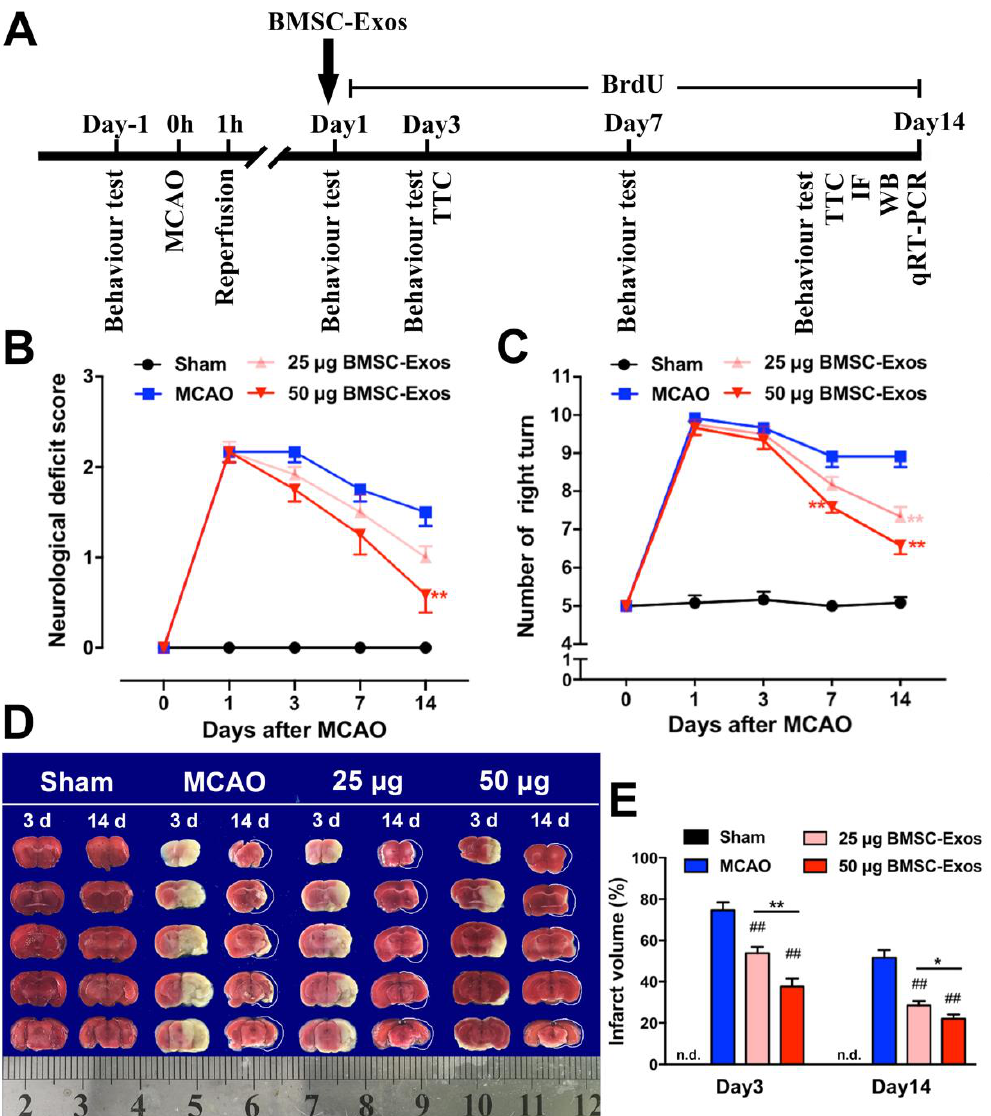
Figure 3. BMSC-Exos administration improved behavioral outcomes and reduced infarction volume in MCAO mice. ( A ) Schematic represents the timeline of in vivo experiments. ( B ) Neurological deficit scores. ( C ) Corner test. n = 12/group. ** p < 0.01 compared with MCAO. ( D ) Representative TTC stained images of mice coronal brain sections at 3 and 14 days after MCAO. White circumscribed line indicates pre-atrophy size of ischemic brain according to the size of contralateral brain. ( E ) Quantification of infract volume. Ruler at the bottom indicates size in centimeters. n = 12/group. ## p < 0.01 compared with MCAO. * p < 0.05 compared with 25 µ g BMSC-Exos group. ** p < 0.01 compared with 25 µ g BMSC-Exos group. BMSC-Exos, bone marrow mesenchymal stem cell-derived exosomes; MCAO, middle cerebral artery occlusion; TTC, 2,3,5-triphenyltetrazolium chloride; n.d., not